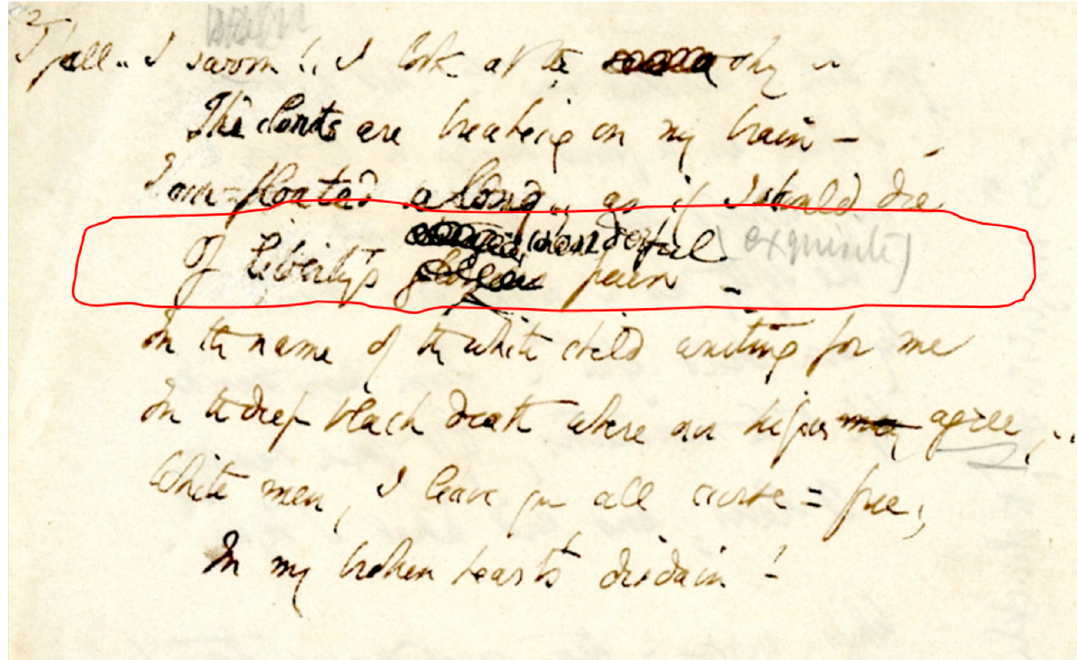
Figure 3. The last stanza in MS D0802 of “The Runaway Slave at Pilgrim’s Point”, one of three portions of the first fair-copy holograph of the poem, with further suggested revisions by Robert Browning in pencil. Two portions, MS D0802 and D0800, are held by the Armstrong Browning Library at Baylor University in Waco, Texas. The revisions discussed above and below are circled in red. Reproduced by permission of the Armstrong Browning Library.